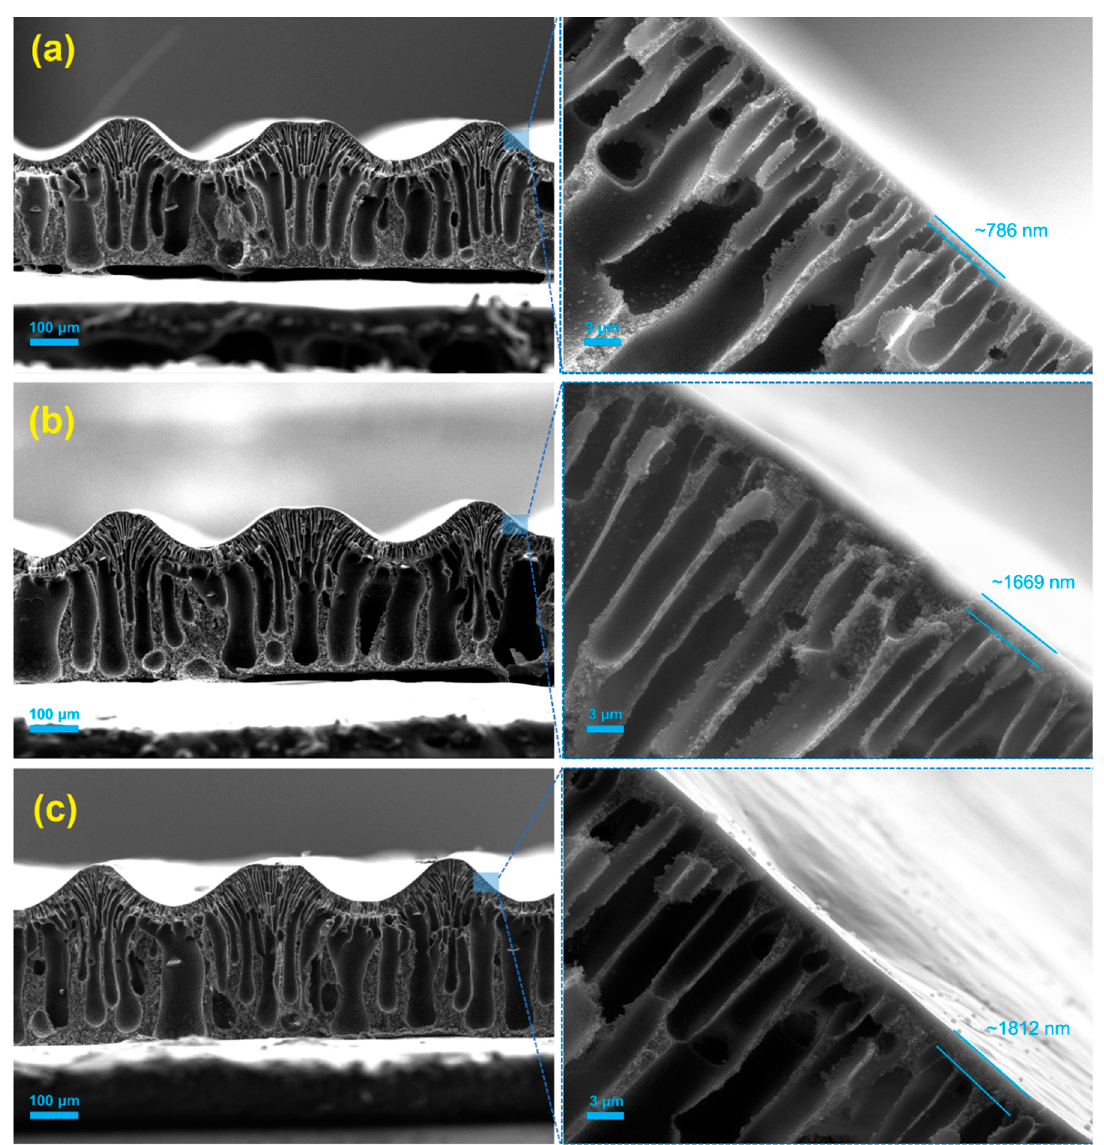
Figure 2. Field emission scanning electron microscopy (FE-SEM) cross-sectional images of ( a ) M1_pristine, ( b ) M2_untreated and ( c ) M3_untreated membranes being fabricated using the same mold without pre-treatment.